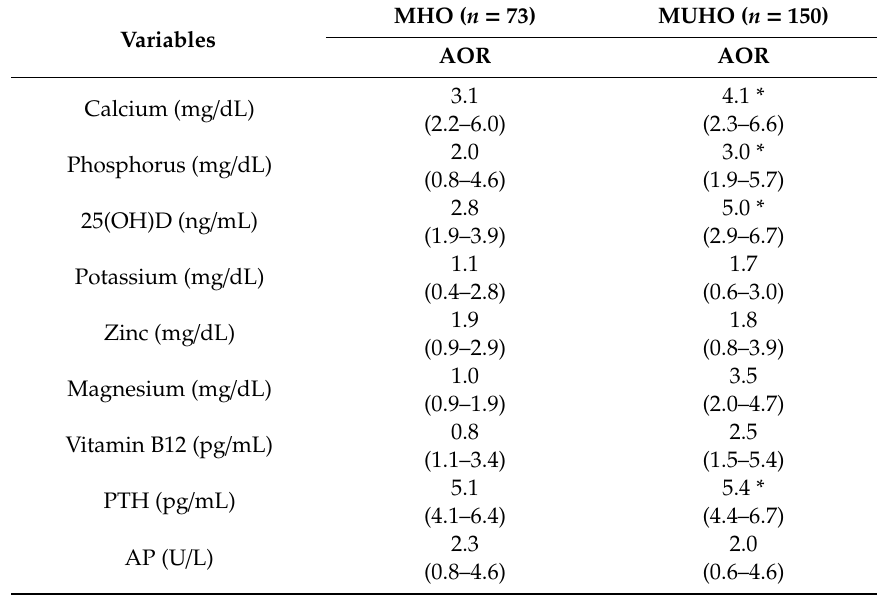
Table 4. Risk factors for alteration in bone metabolism according to the MHO and MUHO